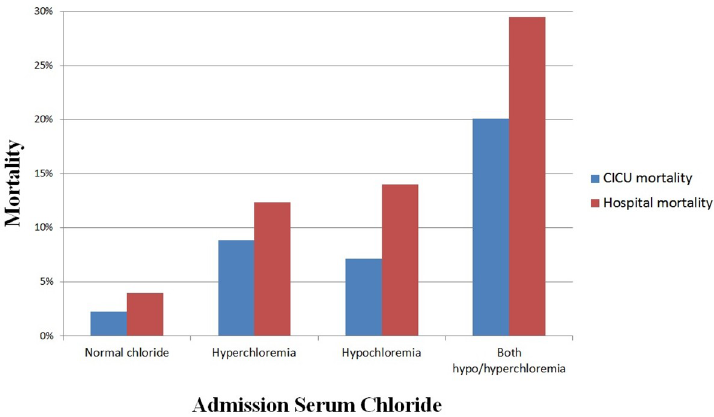
Fig 4. CICU and hospital mortality during hospitalization as a function of hypochloremia and hyperchloremia during the CICU stay. Hypochloremia is defined as chloride < 98 mEq/L and hyperchloremia is defined as chloride � 108